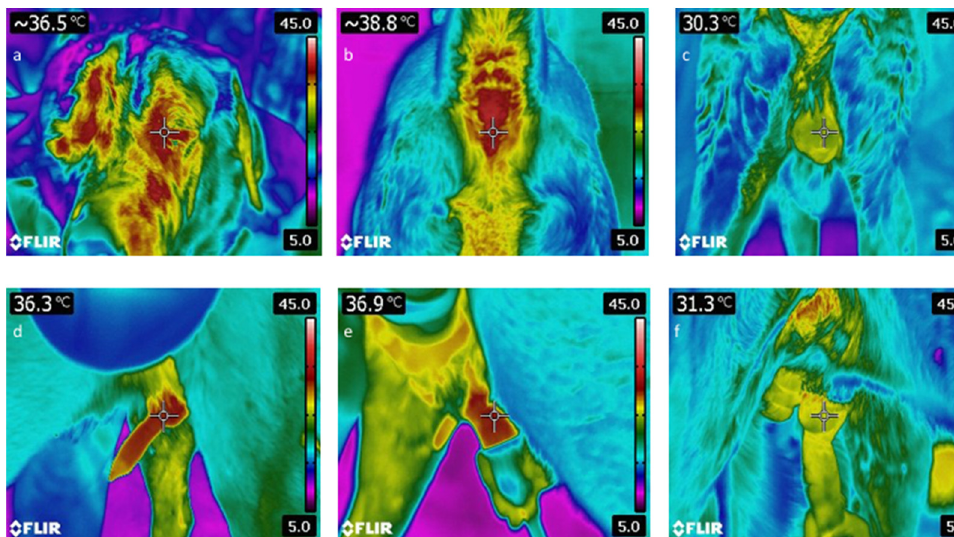
Figure 2. Thermal monitoring of body temperature and external reproductive organs before, during and after ejaculation. ( a ) Eye temperature before ejaculation; ( b ) Perianal temperature before ejaculation; ( c ) Scrotum before ejaculation; ( d ) Bulbus before ejaculation; ( e ) Penis during ejaculation; ( f ) Bulbus after ejaculation.